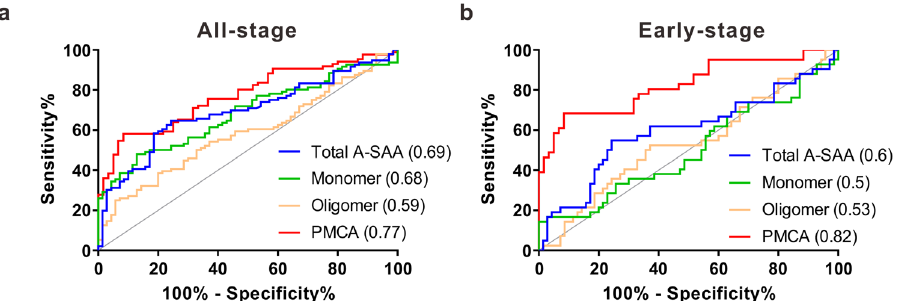
Figure 4. ROC curves of A-SAA derived biomarkers in differentiating all-stage and early-stage HCC in all patients. ( a ) Detection of all-stage HCC. ( b ) Detection of early-stage HCC. AUROC value for each curve is shown in